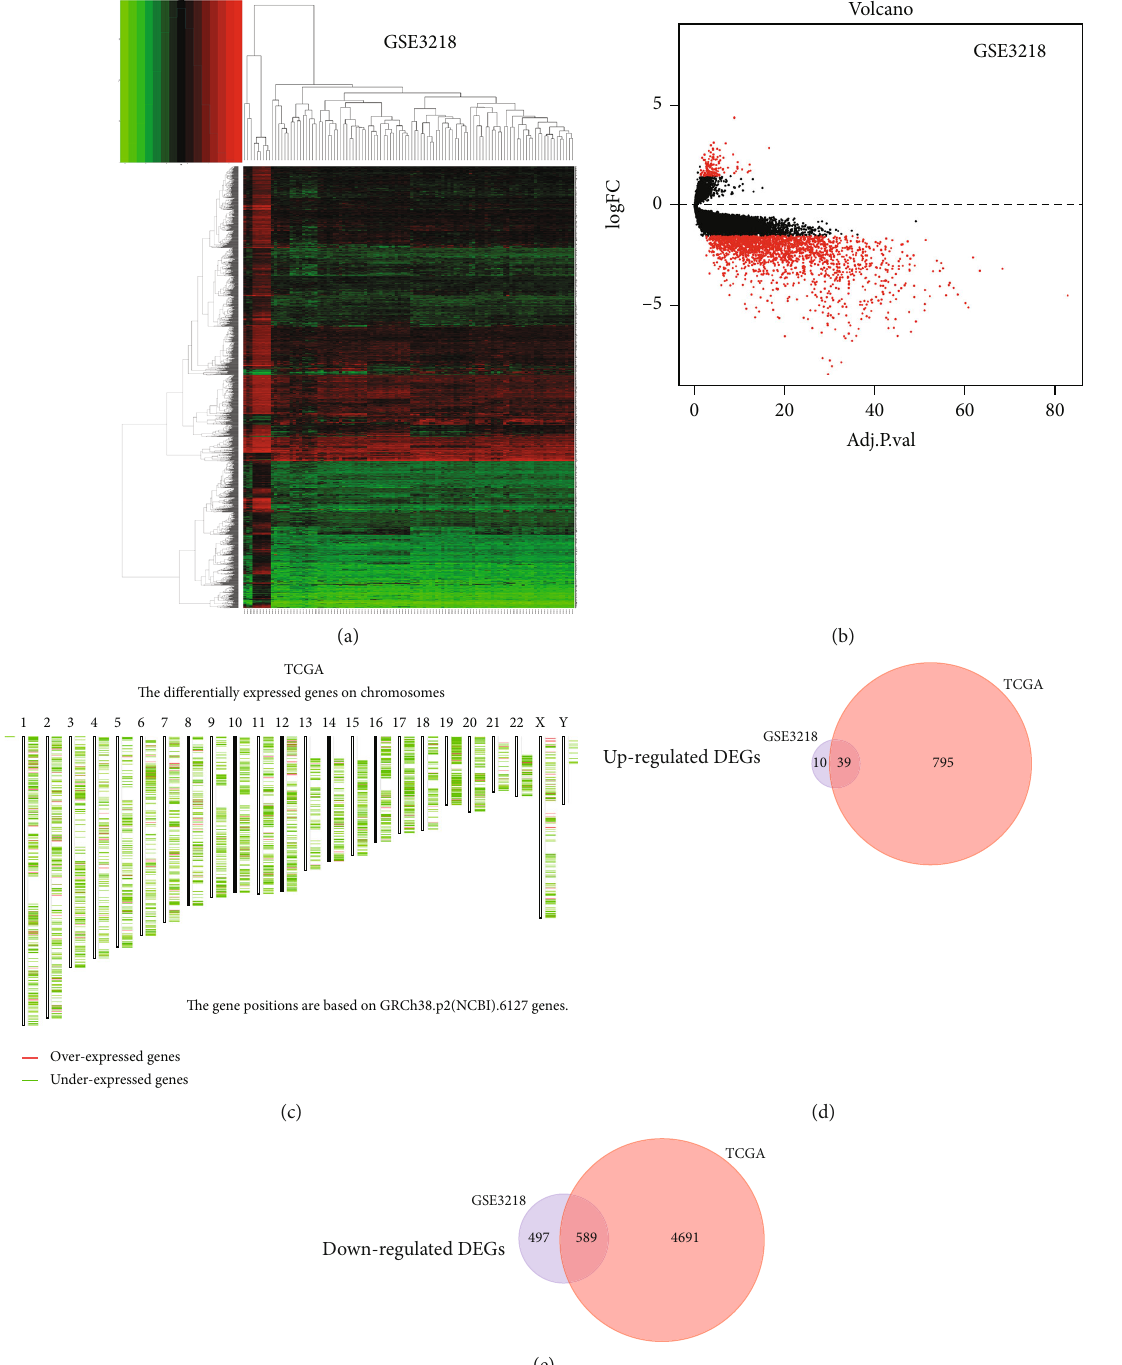
Figure 1: Identi fi cation of di ff erentially expressed genes in TGCT. (a) Heatmap of GSE3218. (b) Volcano plot of GSE3218. (c) The location of di ff erentially expressed genes of TCGA on chromosomes. Red represents overexpressed genes, and blue represents underexpressed genes. (d, e) Venn diagram of DEGs among GSE3218 and TCGA